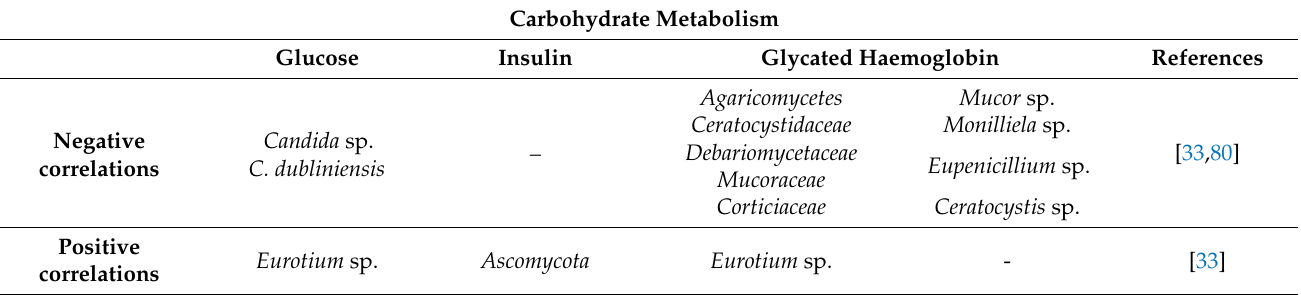
Table 4. The list of negative and positive correlations between carbohydrate metabolism indices and gut mycobiome